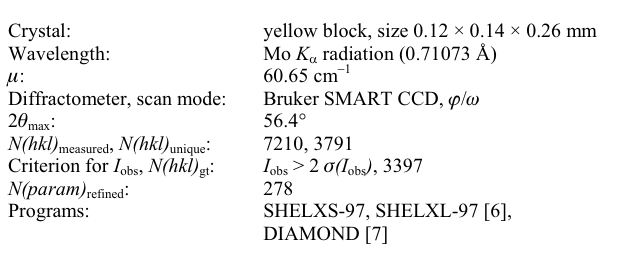
Table 1. Data collection and handling.